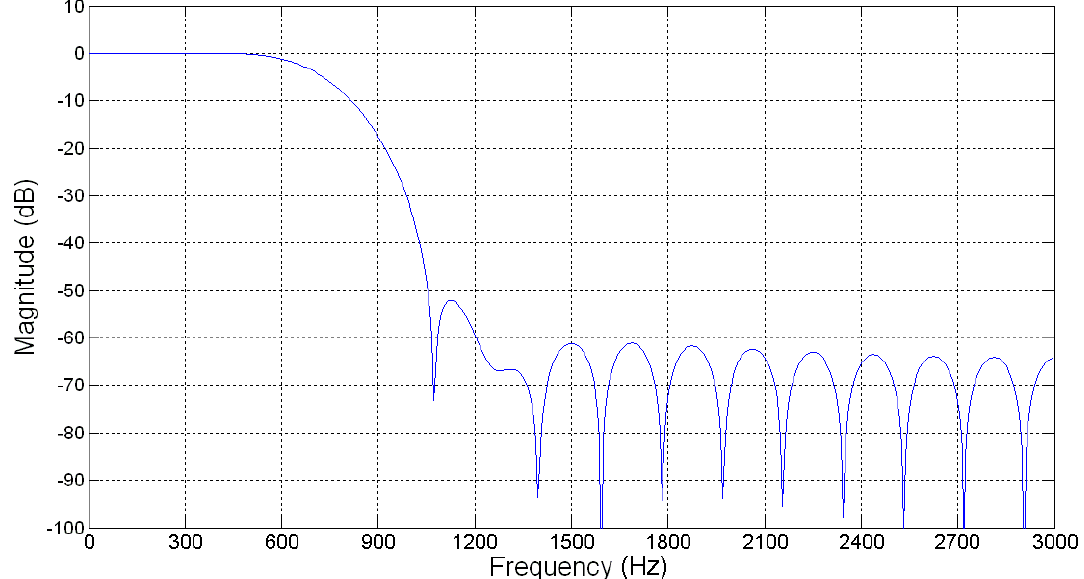
Figure 5. Frequency response of the FIR LPF at 4-times